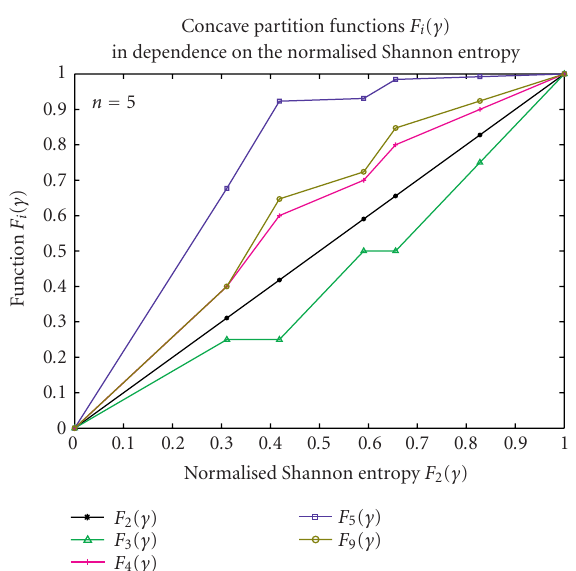
Figure 4.15. Dependence of concave partition functions F i ( γ ) on the normalised Shannon entropy of the Young diagrams in case of n =